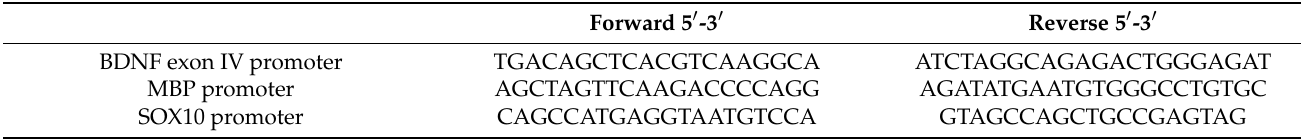
Table 2. Primer set for ChIP